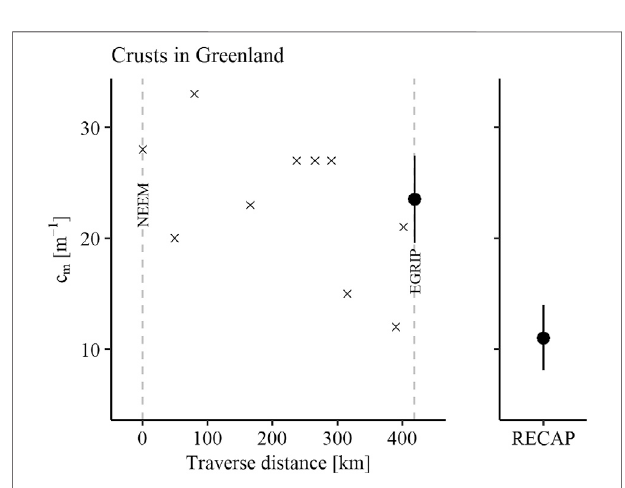
FIGURE 5 | Crust concentration in snow pro fi les from the NEEM to EGRIP traverse. We used the same symbols as in Figure 4 .